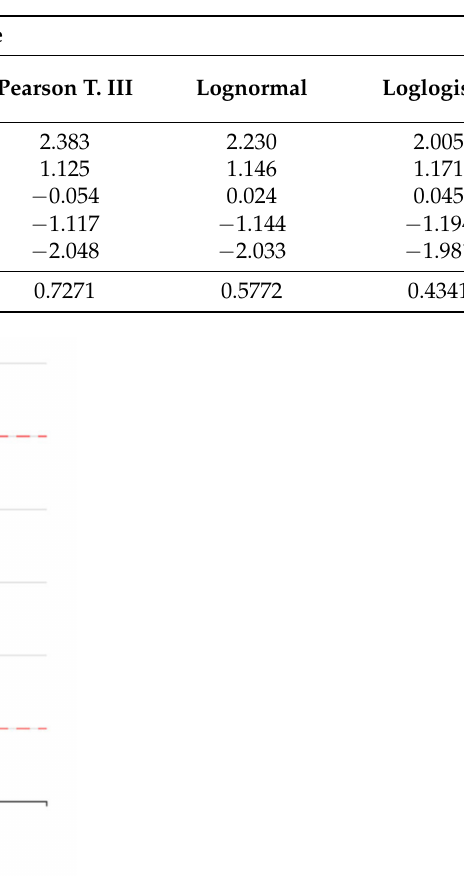
Table 3. Z-values extracted from Figure 6 (6-h rainfall time series) for specific cumulative probabilities.